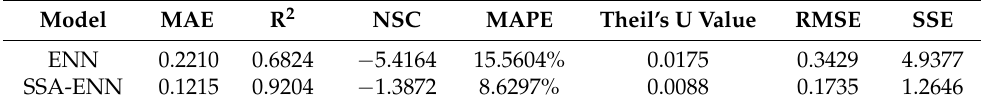
Table 4. Evaluation index values of ENN and SSA-ENN models.